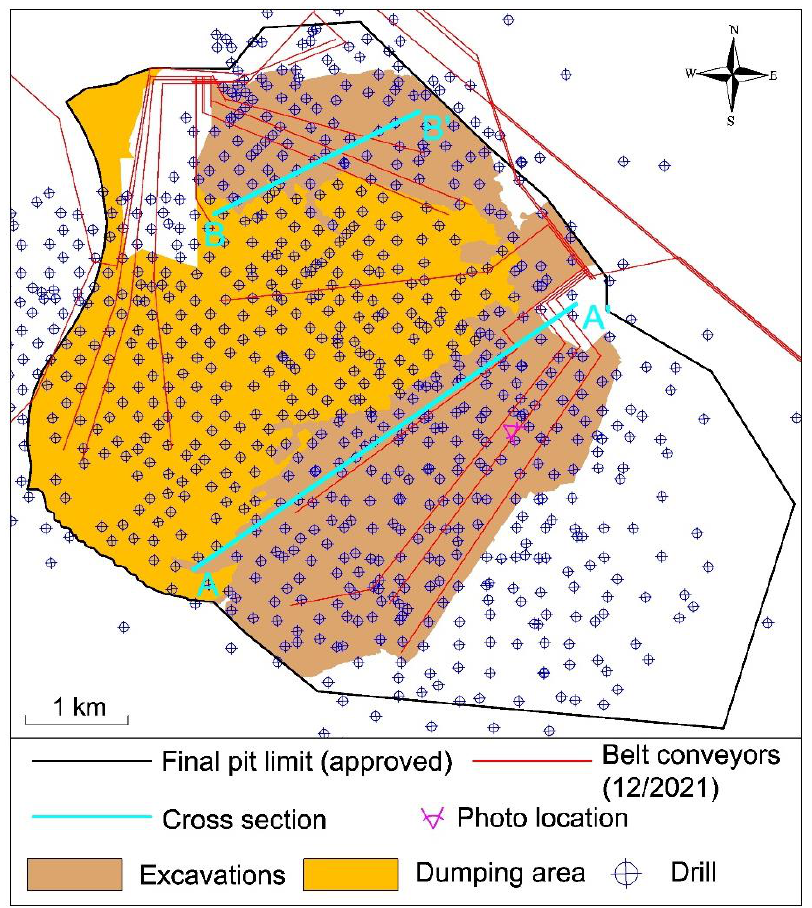
Figure 3. South Field Mine, drills, and location of cross sections and photo .